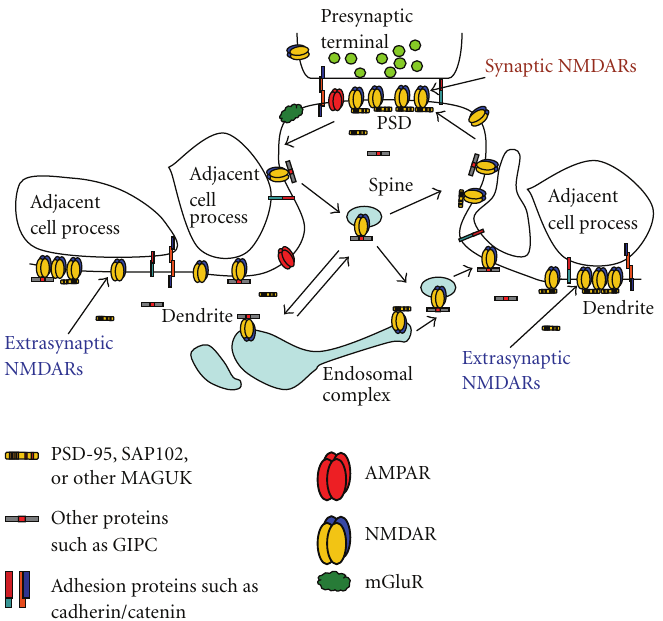
Figure 4: Diagram illustrating the synaptic and extrasynaptic distributions of NMDARs and associated sca ff olding and adhesion proteins, and especially the associations of extrasynaptic NMDARs with adjacent cell processes (see text for details). Although not discussed in this paper, note that other GluRs (AMPARs, kainate and delta iGluRs, and metabotropic GluRs [mGluRs]) are found at synapses and in extrasynaptic locations. AMPARs are typically the most abundant GluRs at synapses and may also be more common than NMDARs in extrasynaptic locations in some neurons. mGluRs are also widespread; some forms are particularly abundant in the perisynaptic zone. Like NMDARs, these GluRs also show close associations with other proteins that a ff ect their tra ffi cking and localization (not illustrated here). The arrangement of di ff erent GluRs such as AMPARs and NMDARs within the synapse has been studied but still is not well defined. And although some AMPARs and NMDARs may tra ffi c together in neurons in early development [18], little is known about the association of these di ff erent types of GluRs in extrasynaptic locations. For reviews, see Gereau and Swanson [1], Lu and Roche [34], and MacGillavry et al. [35]. Diagram modified from Figure 9 of Petralia et al.